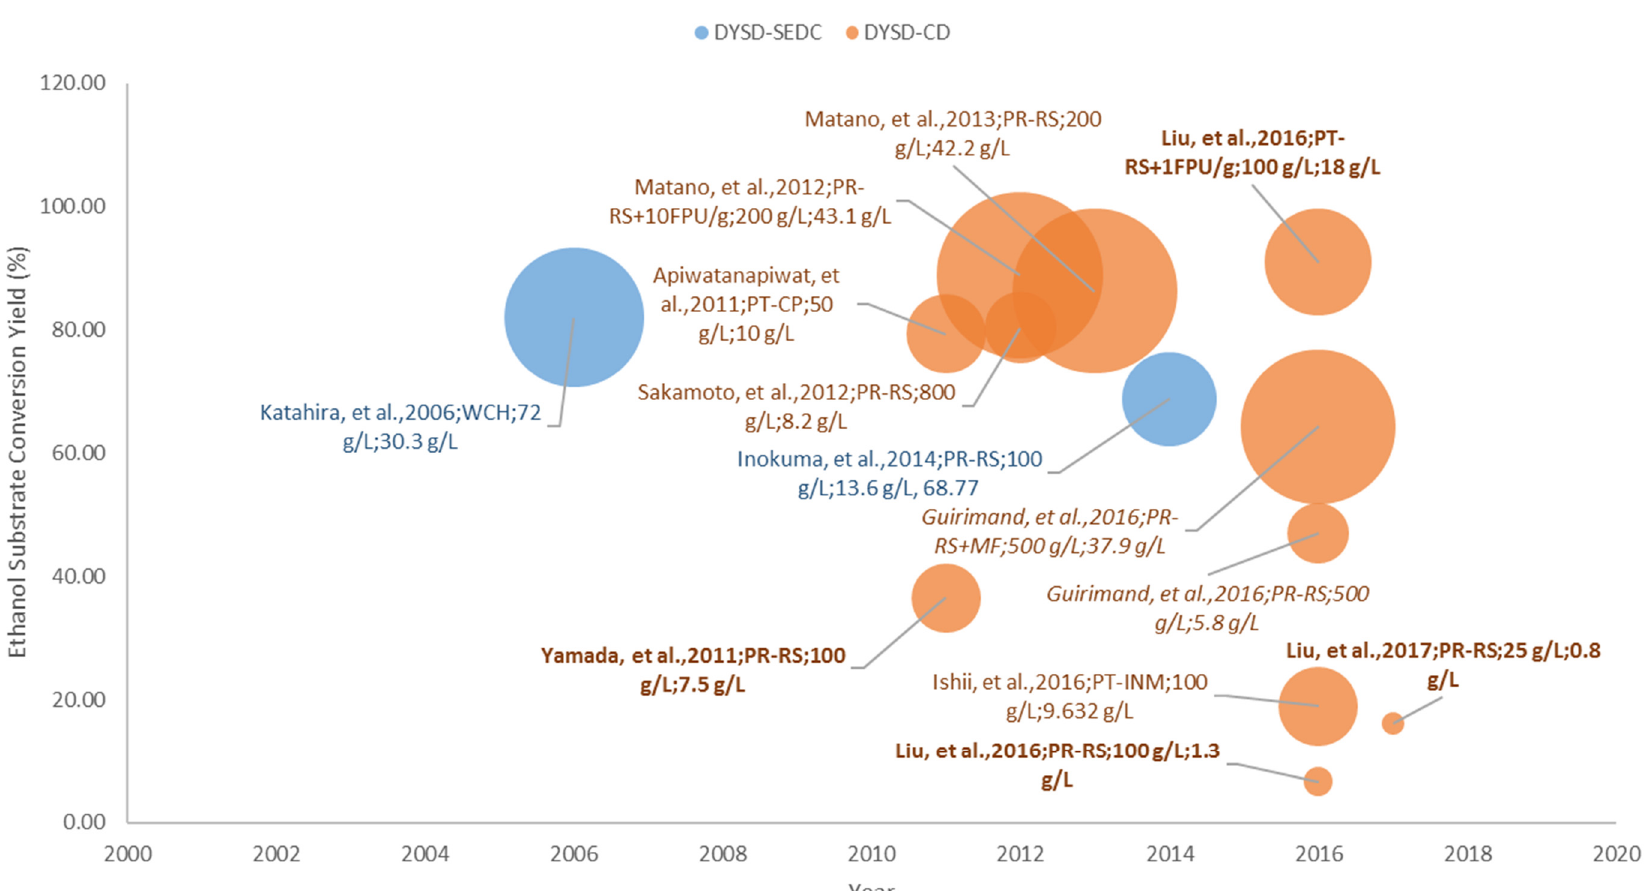
Figure 8. Visualization of the status and development of yeast surface display for Bioethanol Production from Pre-Treated Lignocellulosic Biomass. Bubble sizes represent ethanol titer. Data labels are formatted as follows: (Reference (author-date); Substrate; Substrate Concentration; Ethanol Titer). For DSYD-CD data sets: labels in boldface represent cellulase ratio control via delta-integration; labels in italic represent the xylitol fermentation parameters instead of ethanol.